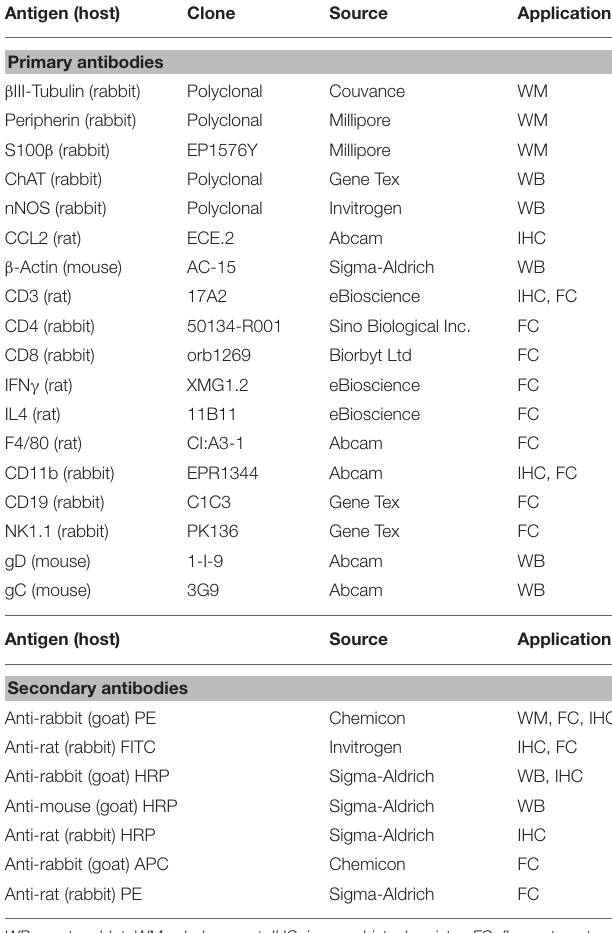
TABLE 1 | Primary and secondary antibodies used in the